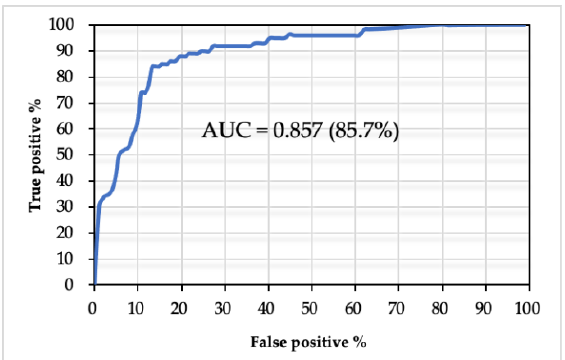
Figure 6. The graph showing validation of landslide susceptibility map under the ROC (AUC) curve using the IDRISI Selva 17.0 software.